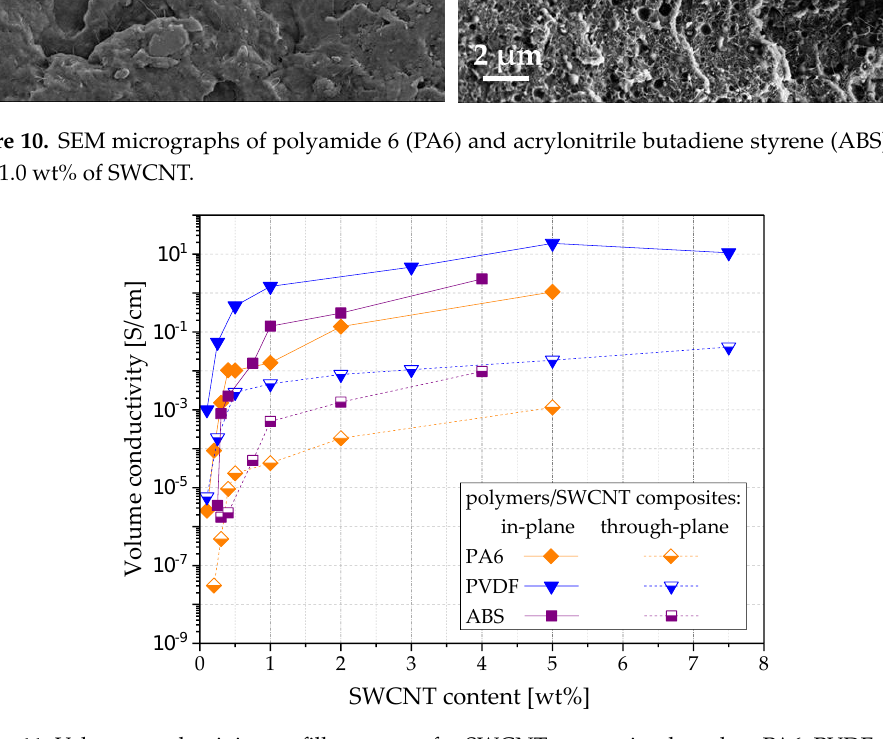
Figure 11. Volume conductivity vs. filler content for SWCNT composites based on PA6, PVDF or ABS matrix, measured in two directions on compression molded plates.